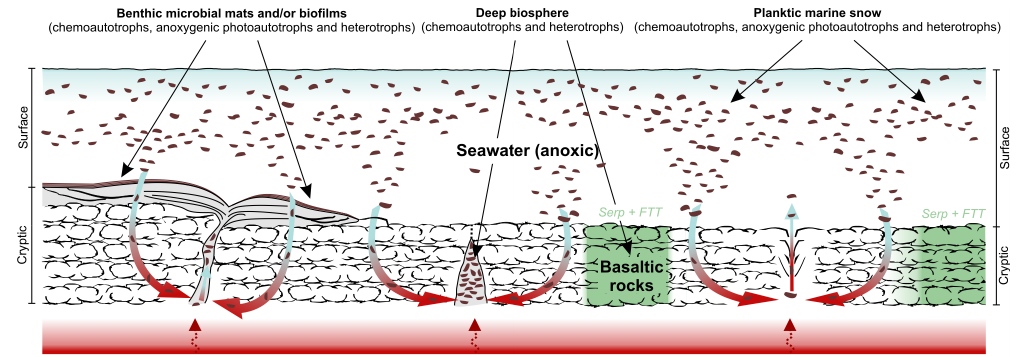
Figure 4. The “hydrothermal pump hypothesis”. Organic matter was predominantly biologically produced and heterotrophically processed by Bacteria and, possibly, Archaea. Additionally, Fischer–Tropsch-type synthesis of organic matter linked to the serpentinization of ultramafic rocks (McCollom et al., 1999; McCollom and Seewald, 2006) may have occurred locally. Primary producers (chemoautotrophs, anoxygenic photoautotrophs) and heterotrophs may have flourished in surface waters (planktic “marine snow”), at the water–rock interface (microbial mats and/or biofilms) and in cryptic environments (e.g. within basalts and hydrothermal vent systems). After accumulating in different Dresser environments, the organic matter was redistributed and sequestered in veins by hydrothermal